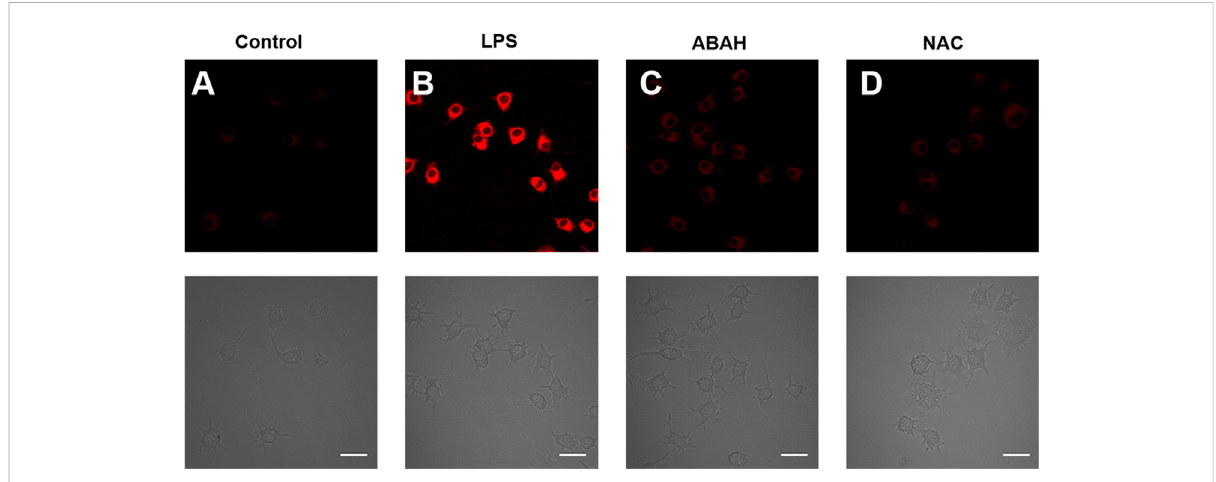
FIGURE 6 Fluorescence microscopic images of exogenous HClO with HDCX-HClO in RAW 264.7 cells. (A) Control group: The RAW 264.7 cells were incubated with the probe for 30 min before being imaged with the probe. (B) Cells were treated with LPS (100 ng/ml) and PMA (100 ng/ml) in a continuous fashion for 24 h before being treated with HDCX-HClO. LPS/PMA (100 ng/ml), (C) ABAH (200 ng/ml), (D) NAC (1 mM), and then incubated with HDCX-HClO were all used to treat the cells in this experiment and the 561 nm and emission at 690 – 770 nm correlated with it. Scale bar = 20 μ m.